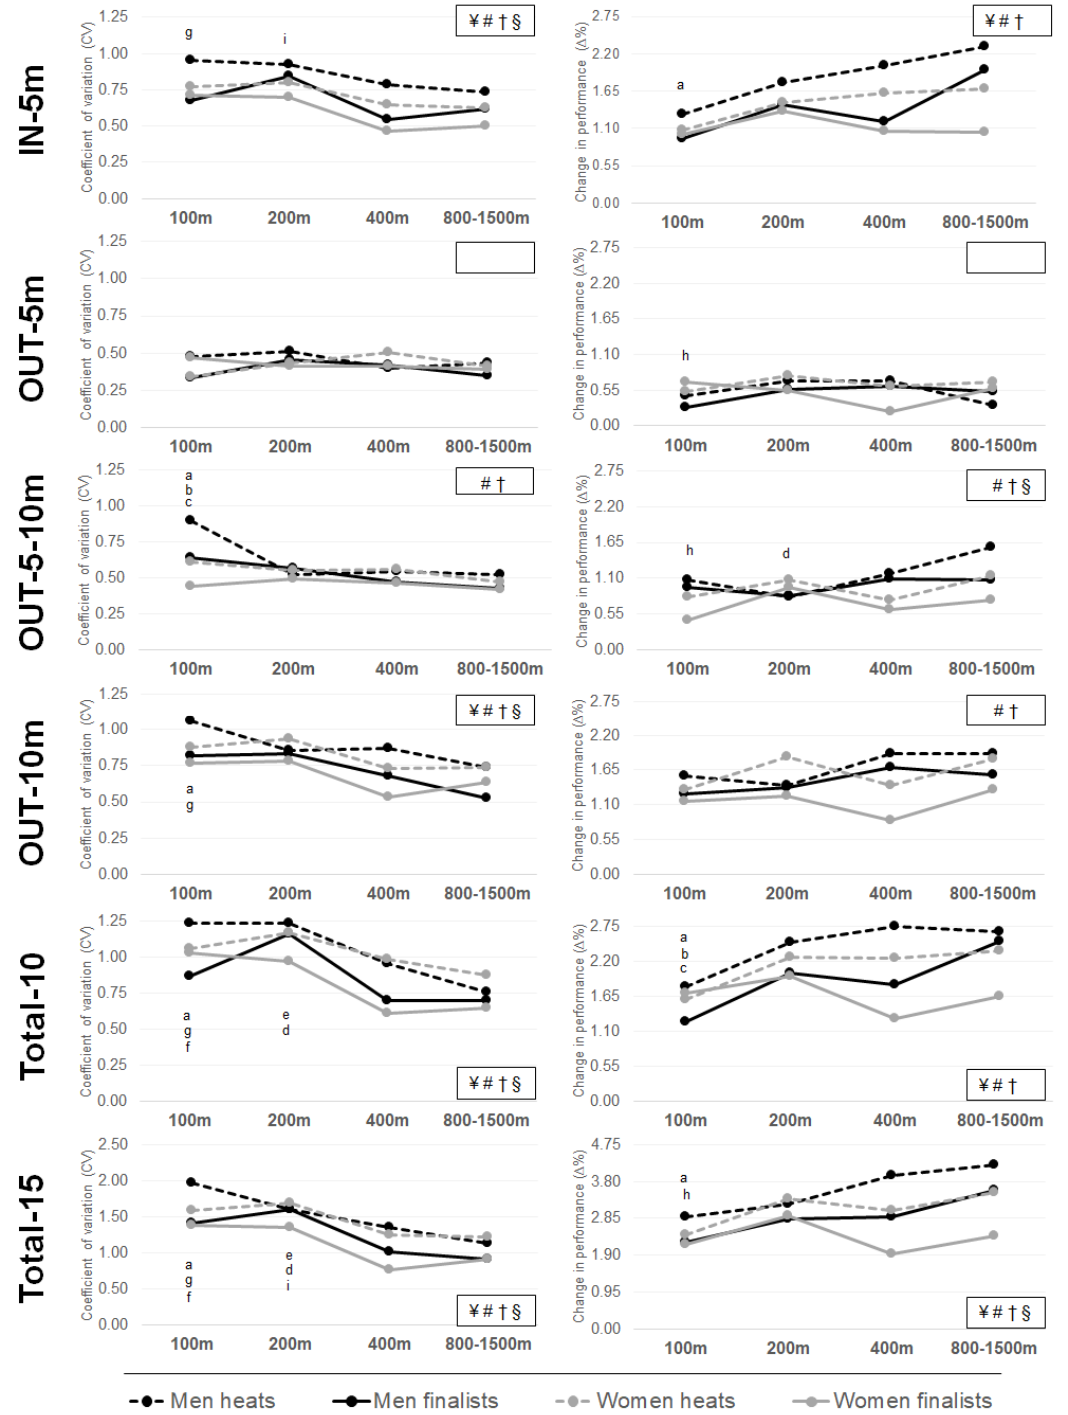
Figure 1. Coefficients of variation and relative changes in performance with ANOVA main effects corre-sponding to performance level and race distance for men and women. A significant main effect for: ¥ performance levels in men; # race distances in men; † performance levels in women; § race distances in women. Significant post-hoc effect in men: (a) between 100 and 1500 m races; (b) between 100 and 400 m races; (c) between 100 and 200 m races; (d) between 200 and 1500 m races; (e) between 200 and 400 m races; the significant difference in women: (f) between 100 and 800 m races; (g) between 100 and 400 m races; (h) between 100 and 200 m races; (i) between 200 and 800 m